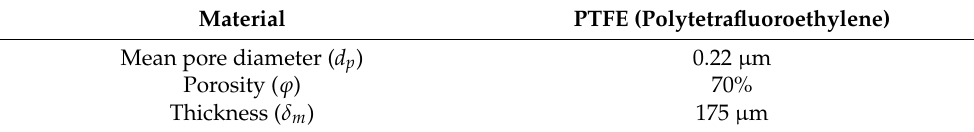
Table 2. Membrane features.